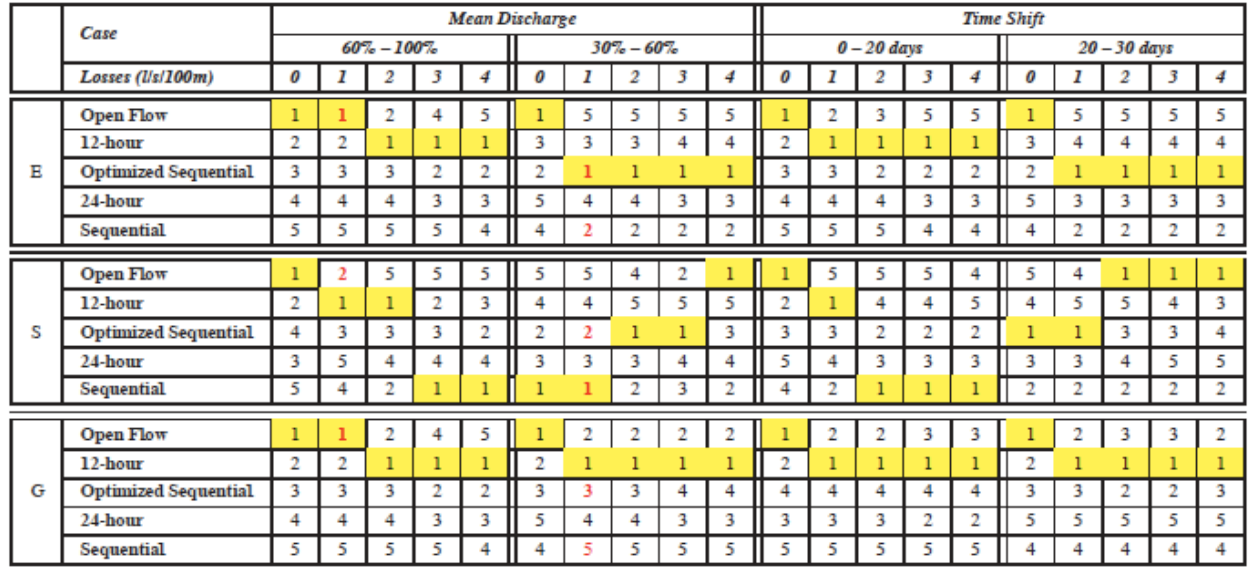
Fig. 12 . Summary of irrigation policy performance. Each policy has been ranked with respect to E: Expected Value, S: Sensitivity, and G: Mean Gini. Yellow blocks indicate the best policy for a given situation, red numbers illustrate what farmers actually do in a given situation, where known. Black numbers refer to the ranking of the performance of each policy, e.g. a black "1" is the optimal policy for a given situation,